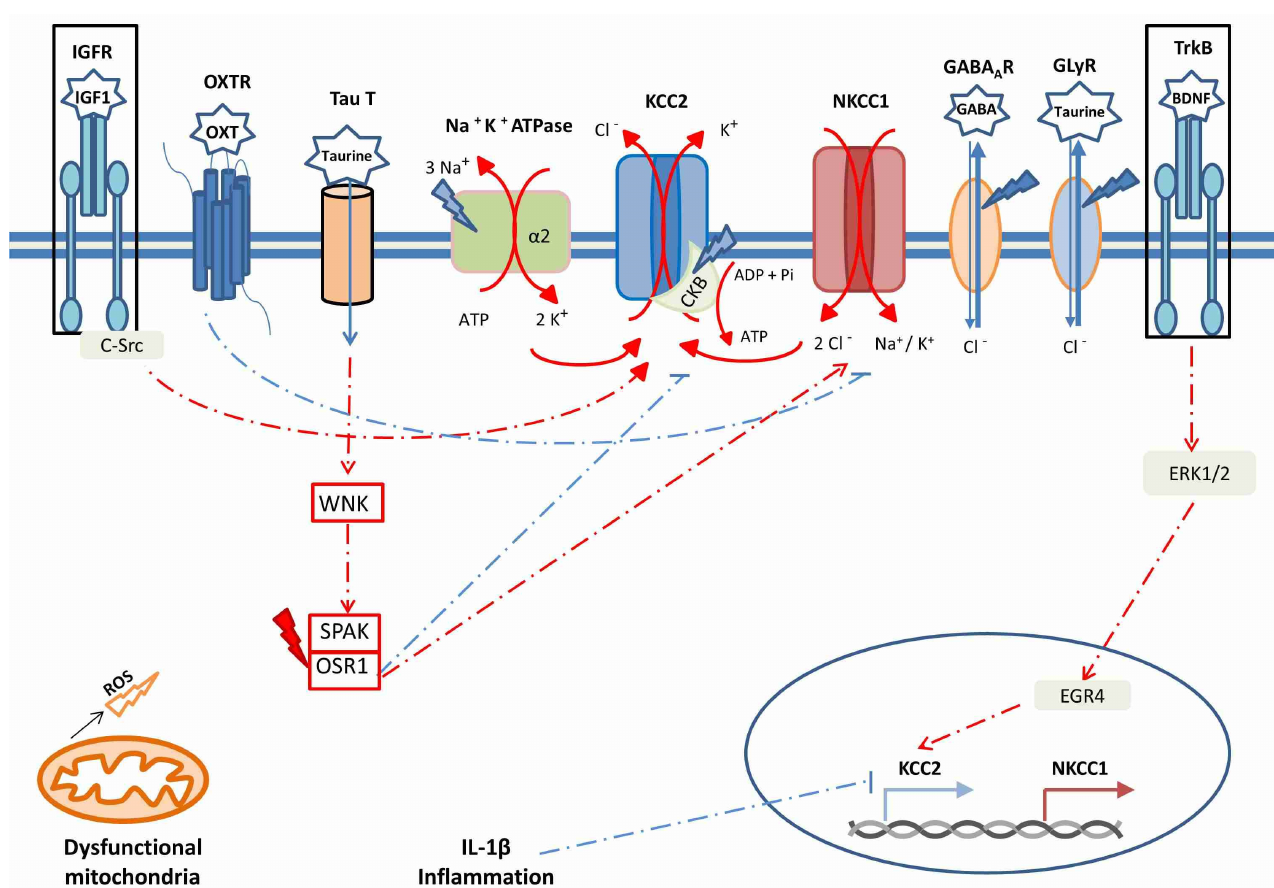
Figure 2. The main factors modulating KCC2 and NKCC1 synthesis and activity, in relation with anomalies described in neurological and neurodevelopmental disorders. Oxidative stress/ROS is symbolized by lightning bolts; blue bolts indicate a loss-of-function effect, red bolts indicate a gain-of-function effect. The boxes surrounding IGFR and TrkB indicate that IGF-1 and BDNF signaling are both decreased in ASD and in other neurodevelopmental disorders.